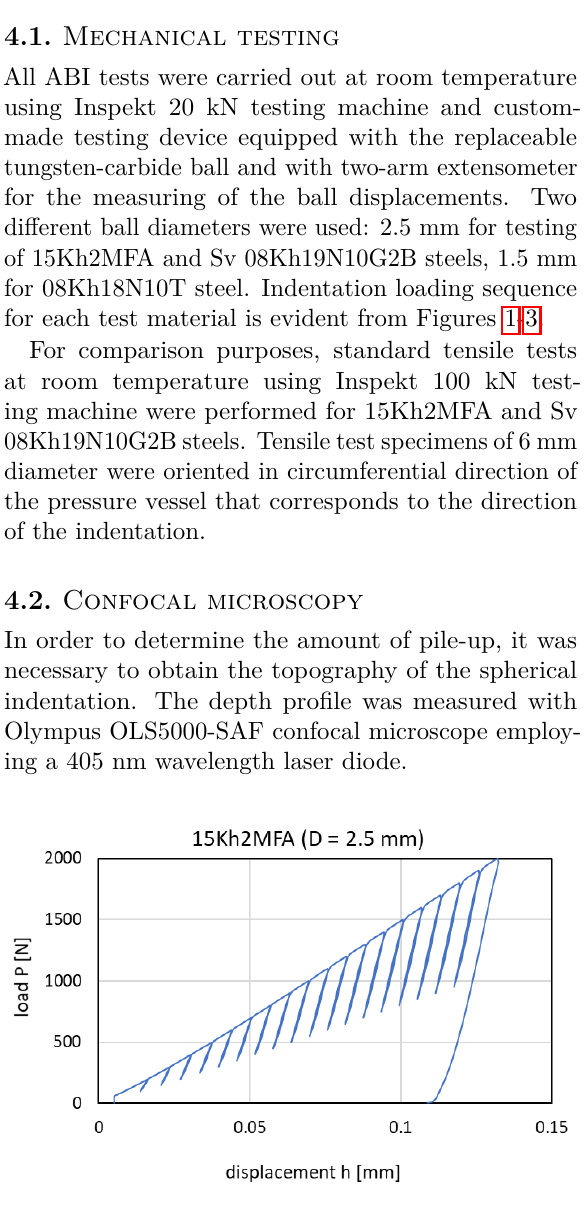
Figure 1. ABI test load - displacement curve for 15Kh2MFA